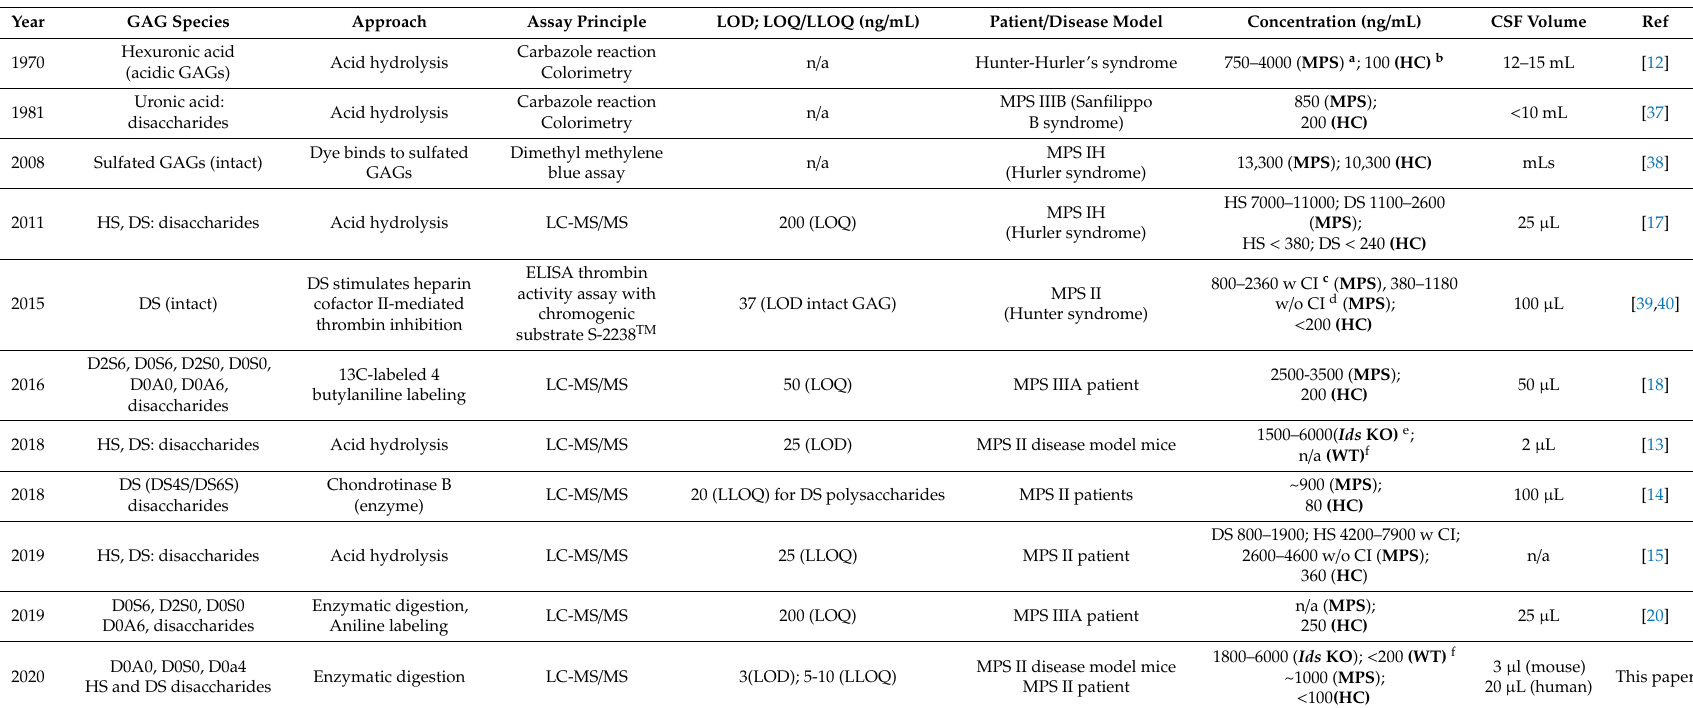
Table 2. A summary of the CSF GAG measurement in MPS patients and animal